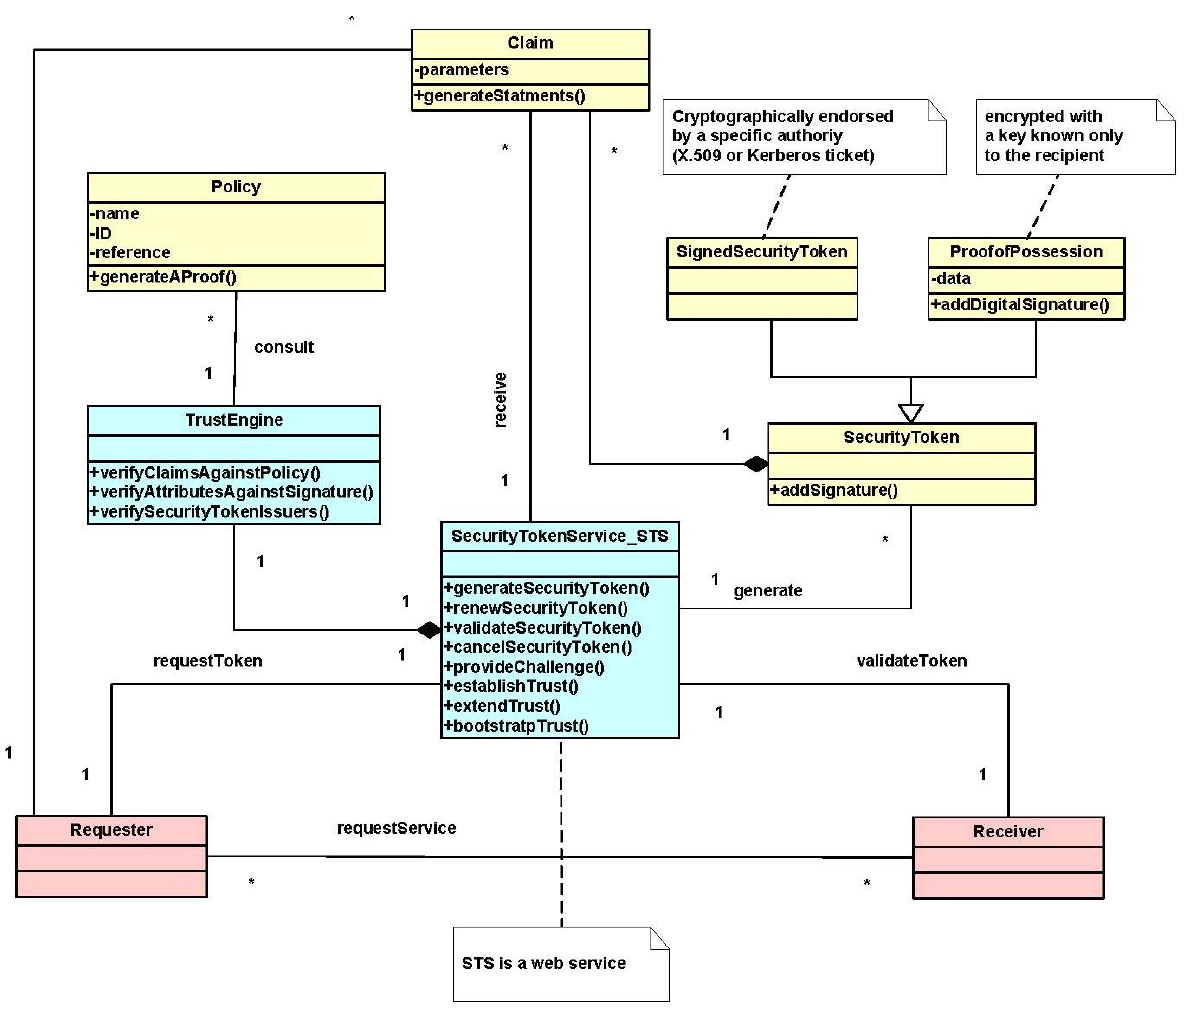
Figure 5. Class Diagram for the WS-Trust